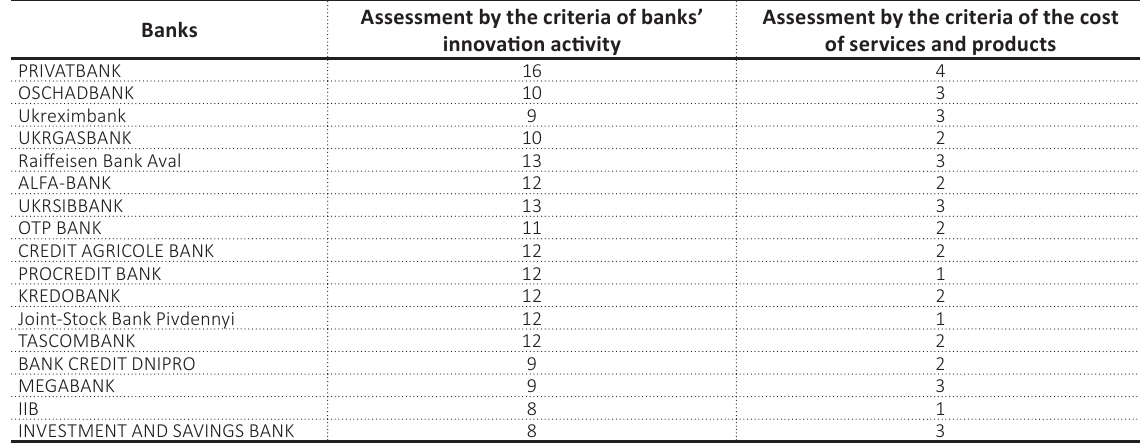
Table 3. Summary of the results obtained upon comparing banks as potential partners for enterprises in terms of comprehensive services